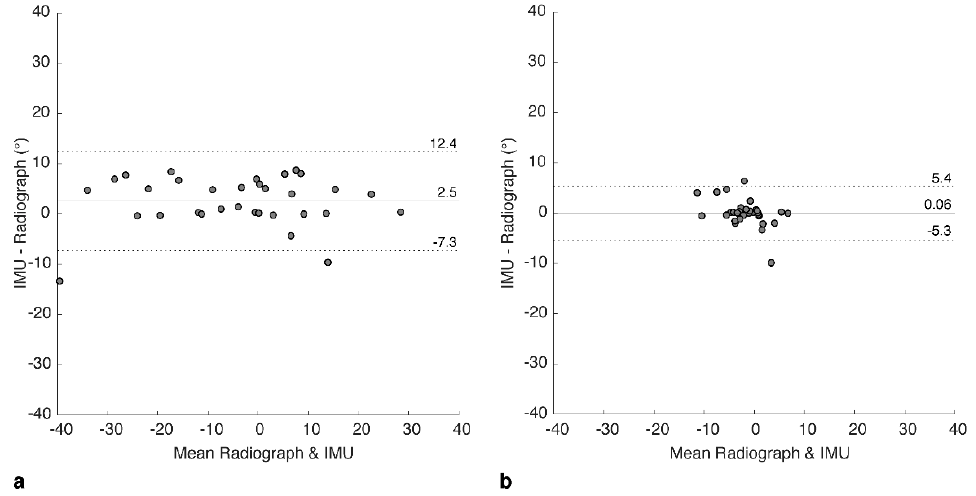
Figure 5. Bland-Altman plots showing difference between IMU and radiograph measures for ( a ) flexed-seated and ( b ) step-up positions. Solid horizontal line indicates bias, dashed lines indicate upper and lower limits of agreement (95% confidence intervals).